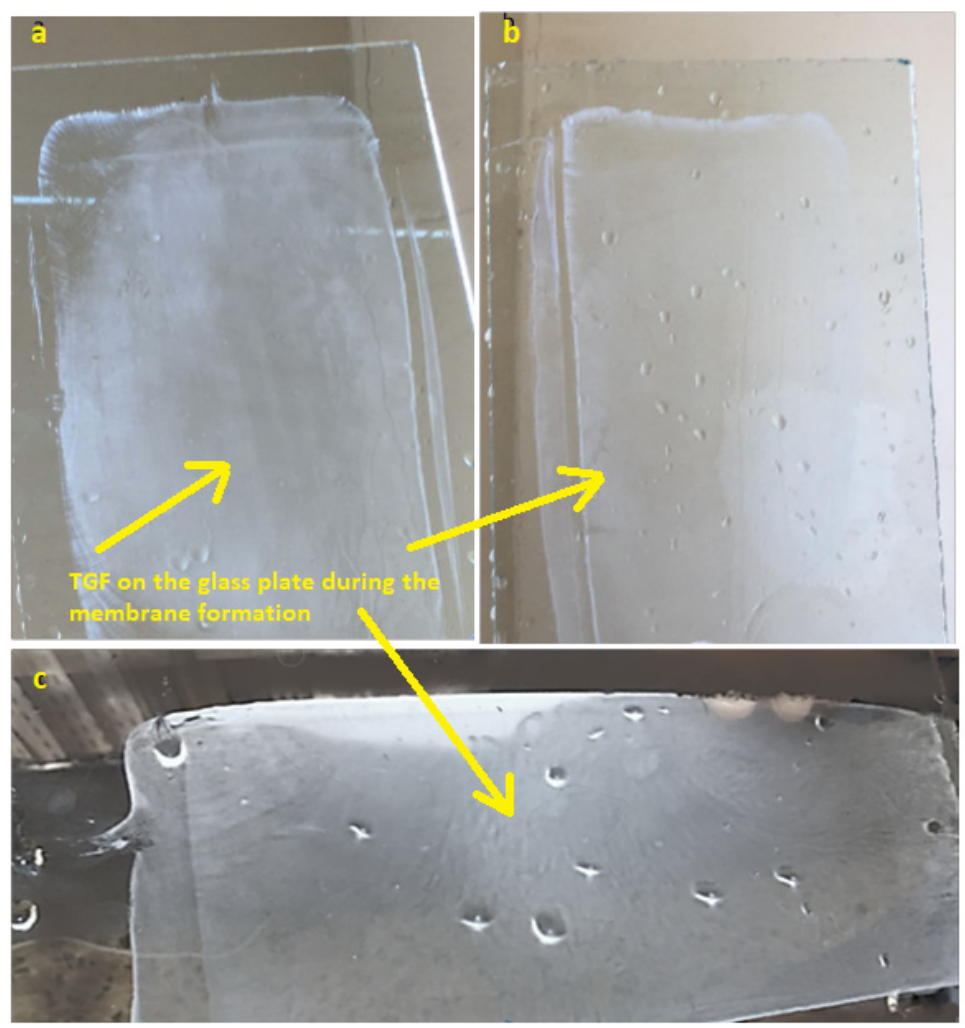
Figure 3. Glass plate of casting solution showing the amount of TGF nano-polymer remaining on the glass surface after formation of the membranes for ( a ) G1, ( b ) G3, and ( c ) G6.